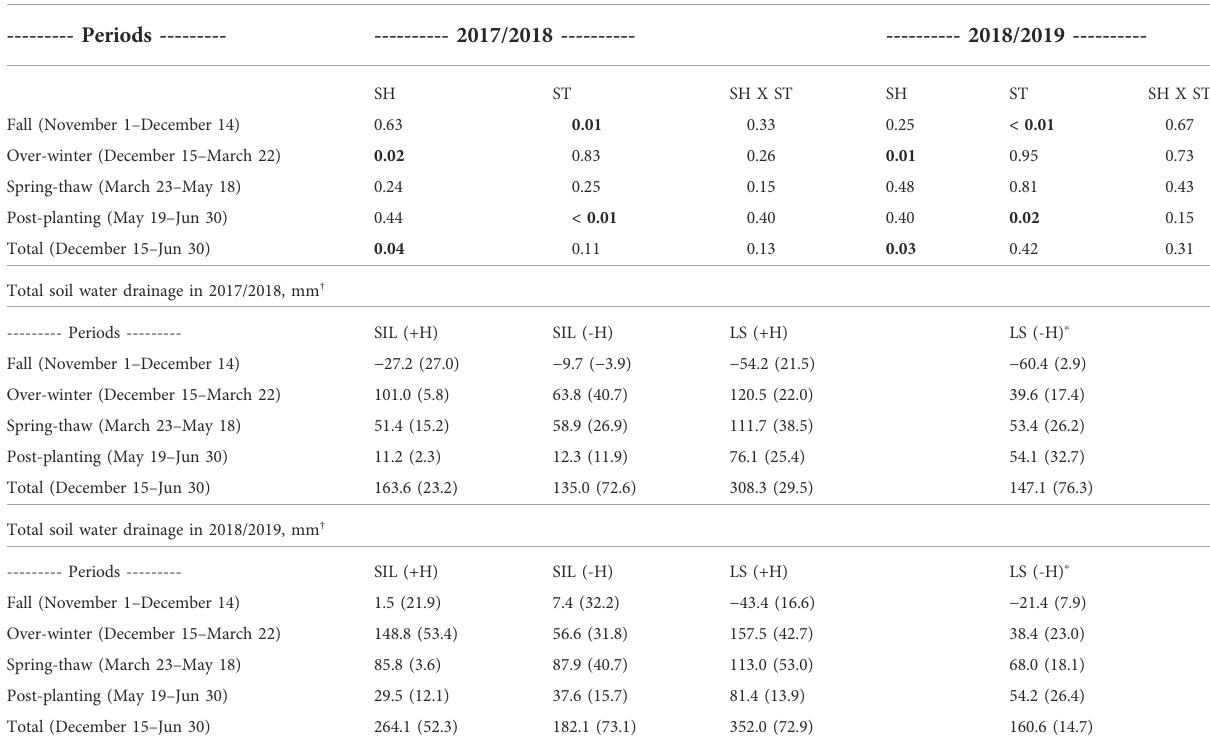
TABLE 1 p -values of the two-way ANOVA used to test main effects (SH, soil heating; ST, soil type) and the interaction SH × ST on the total drainage during periods of the 2017/2018 and 2018/2019 seasons, and respective totals (standard deviation is shown in parenthesis). Bolded values indicate p ≤